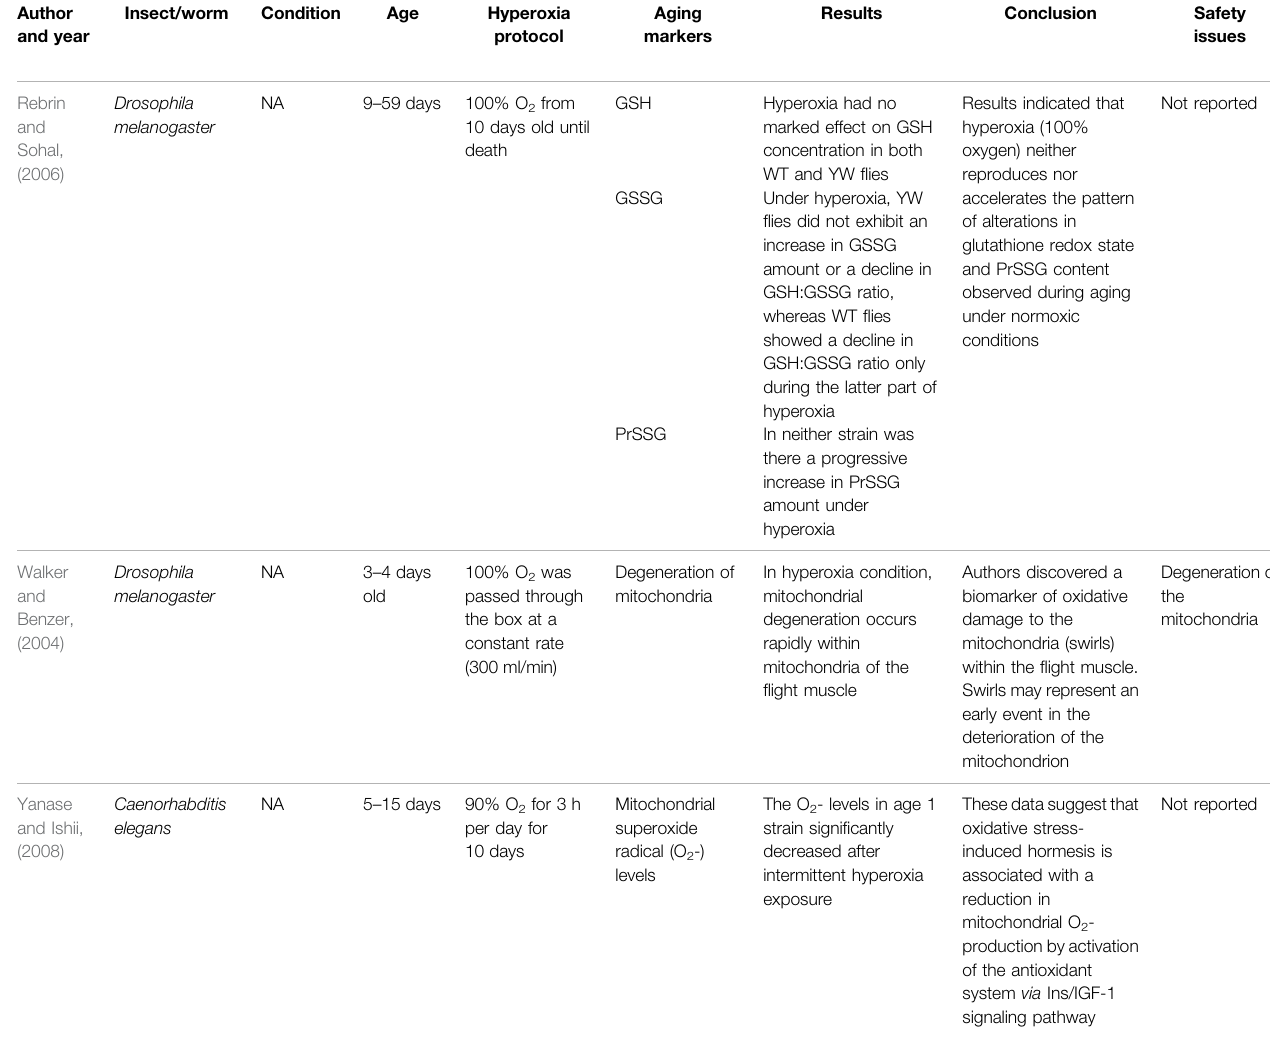
TABLE 4 | The effect of hyperoxia on aging markers in insects and